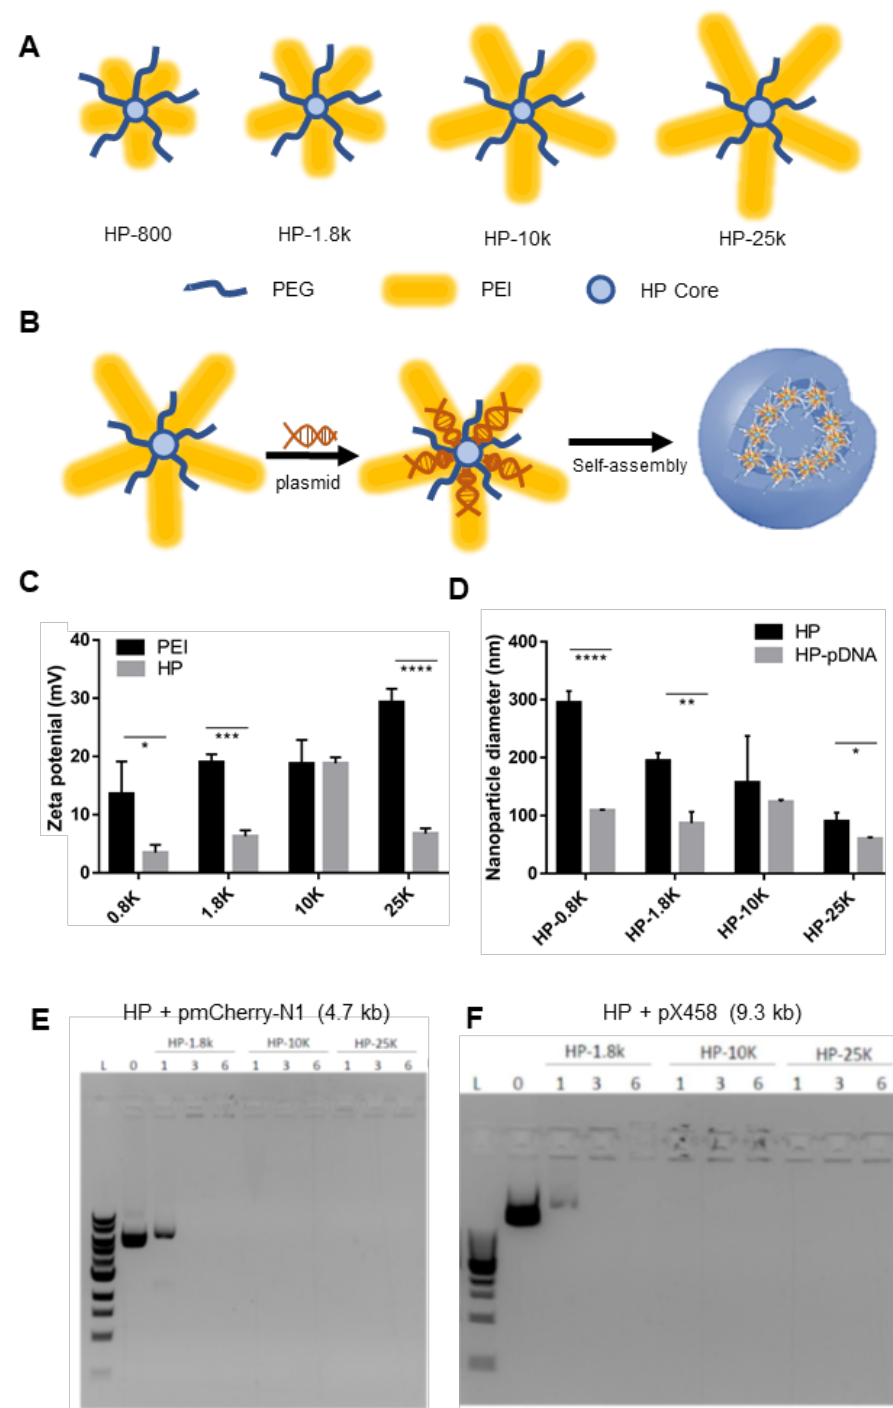
Figure 1. HP nanoparticle design and characterization. ( A ) Illustration of the design of HP- nanoparticles. Blue arm is PEG, yellow is PEI (larger PEI shape referring to higher PEI molecular weight), light blue is HP core. ( B ) Illustration of the double shelled polyplexes formed by HP nanoparticles and pDNA. ( C ) Zeta potential of HP nanoparticles and PEI of the same chain lengths. ( D ) Diameters of HP nanoparticles with or without packaging pmCherry-N1 (4.7 kb) pDNAs determined by Dynamic Light Scattering. ( E ) Gel retardation assay of HP and pmCherry-N1 (4.7 kb) polyplexes at various N/P ratios (1, 3, 6). ( F ) Gel retardation assay of HP and pX458 (9.3 kb) polyplexes at various N/P ratios (1, 3, 6). * p < 0.05. ** p < 0.01. *** p < 0.001. **** p < 0.0001 .